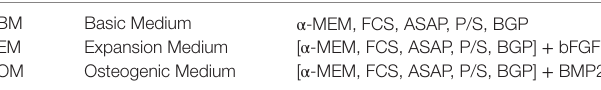
TaBle 1 | Different media used for this